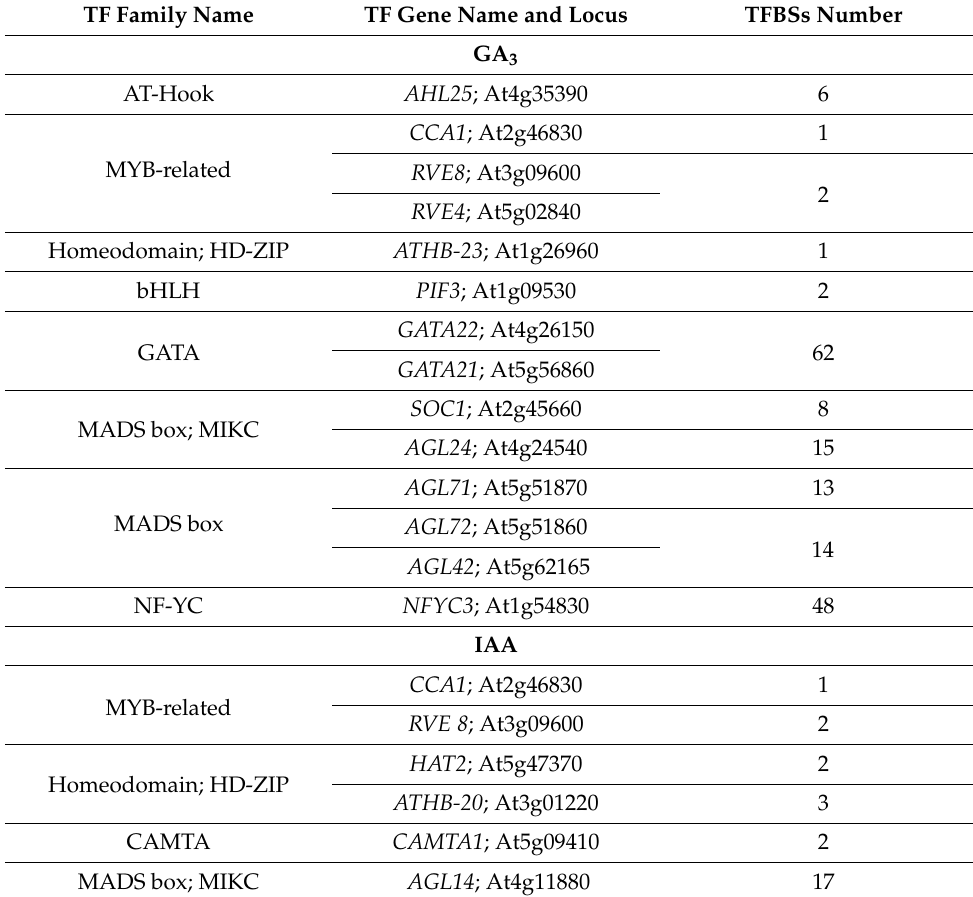
Table 1. Potential transcription factors (TFs) that bind to the Salvia miltiorrhiza HMGR4 promoter sequence and respond to gibberellic acid (GA 3 ), indole-3-acetic acid (IAA), salicylic acid (SA) signals found using PlantPan 2.0